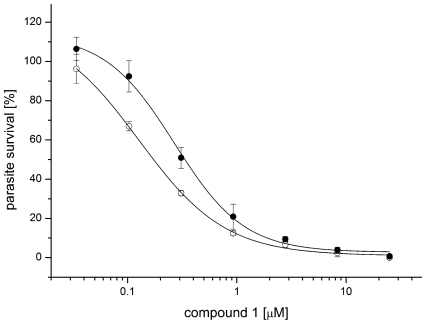
Dose-response curve for parasite growth in presence of compound 1.RNAi-mediated silencing of TbAK expression by tetracycline (•) reduces sensitivity of TbAK RNAi cells to compound 1 when compared to non-induced cells (○), raising the IC50 from 131±43 nM to 271±25 nM (two-tailed t-test, p<0.05).